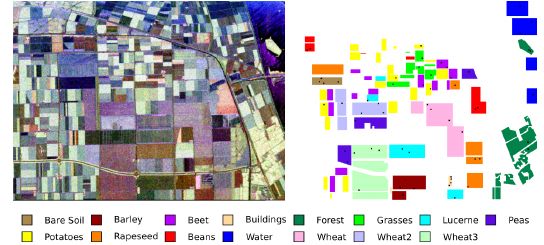
Figure 5. Flevoland image (left) and ground truth labels (right). Training samples are marked as black squares (best viewed with